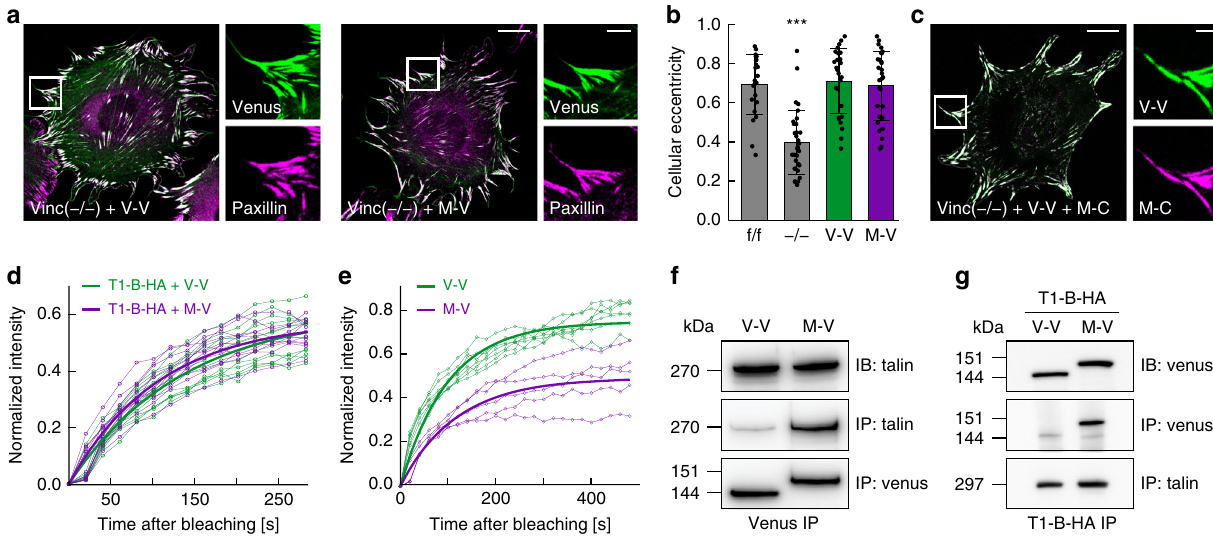
Fig. 1 Metavinculin is immobilized in focal adhesions (FAs) and displays enhanced binding to talin. a Representative images of vinculin-de fi cient (vinc ( − / − ) ) cells expressing vinculin – venus (V-V) or metavinculin – venus (M-V). Co-staining with a paxillin antibody indicates the independent localization of each vinculin isoform to FAs. b V-V and M-V both rescue the spreading defect of vinc ( − / − ) cells, which display reduced cellular eccentricity 2 h after cell adhesion when compared to the parental cell line (vinc (f/f) ). ( n = 23, 32, 27, 30 cells). Two-sided Kolmogorov – Smirnov test: *** p < 0.001. The bar chart shows the mean values ± SD. c V-V and metavinculin – mCherry (M – C) co-localize in FAs when co-expressed in vinc ( − / − ) cells. d Talin turnover rates are comparable in V-V- or M-V-expressing vinc ( − / − ) cells, as revealed by FRAP analysis of cells with co-expressed talin-1-TagBFP-HA (T1-B-HA). ( n = 12, 12 cells). e Metavinculin resides in FA longer than vinculin as shown by FRAP analysis of vinc ( − / − ) cells expressing V-V or M-V. ( n = 7, 5 cells). f Co-immunoprecipitation (IP) experiments using the venus-tag as bait demonstrate an increased association of talin with metavinculin (IB: immunoblot). g Metavinculin is enriched in an HA-tag-driven IP performed on cells co-expressing T1-B-HA and V-V or M-V. Scale bars indicate 20 µ m, in zoom: 5 µ m. Expected molecular weight values are indicated (kDa). Source data, exact p values, and uncropped immunoblots with protein markers are provided in the Source Data fi